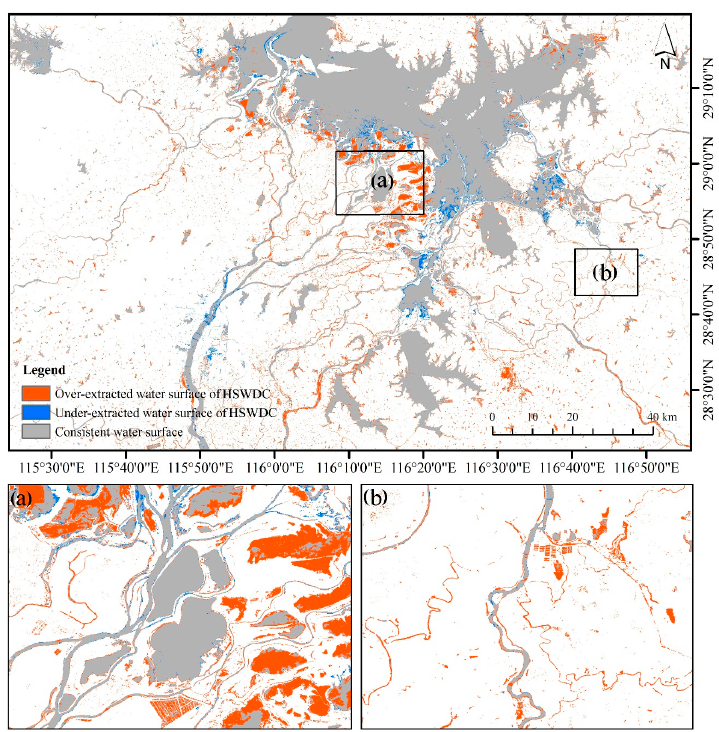
Figure 7. Comparison of Poyang Lake in August 2018 from the HSWDC and the GSWE. The region where both HSWDC and GSWE are recognized as water is shown in grey. Based on GSWE, the over-extracted water surface of HSWDC is shown in orange, and the under-extracted water surface of HSWDC is shown in blue. ( a ) and ( b ) are two local regions of Poyang Lake.